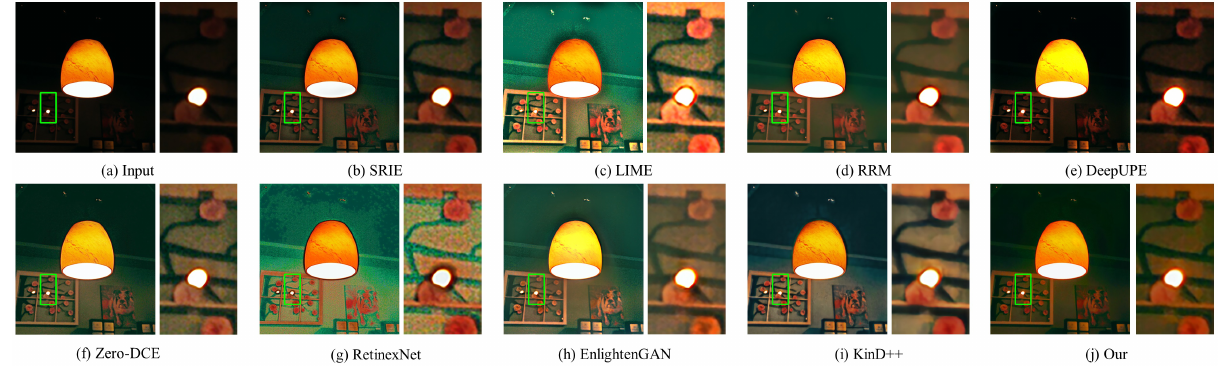
Figure 4. Visual comparison of low-light image enhancement on an image from the LOL dataset.